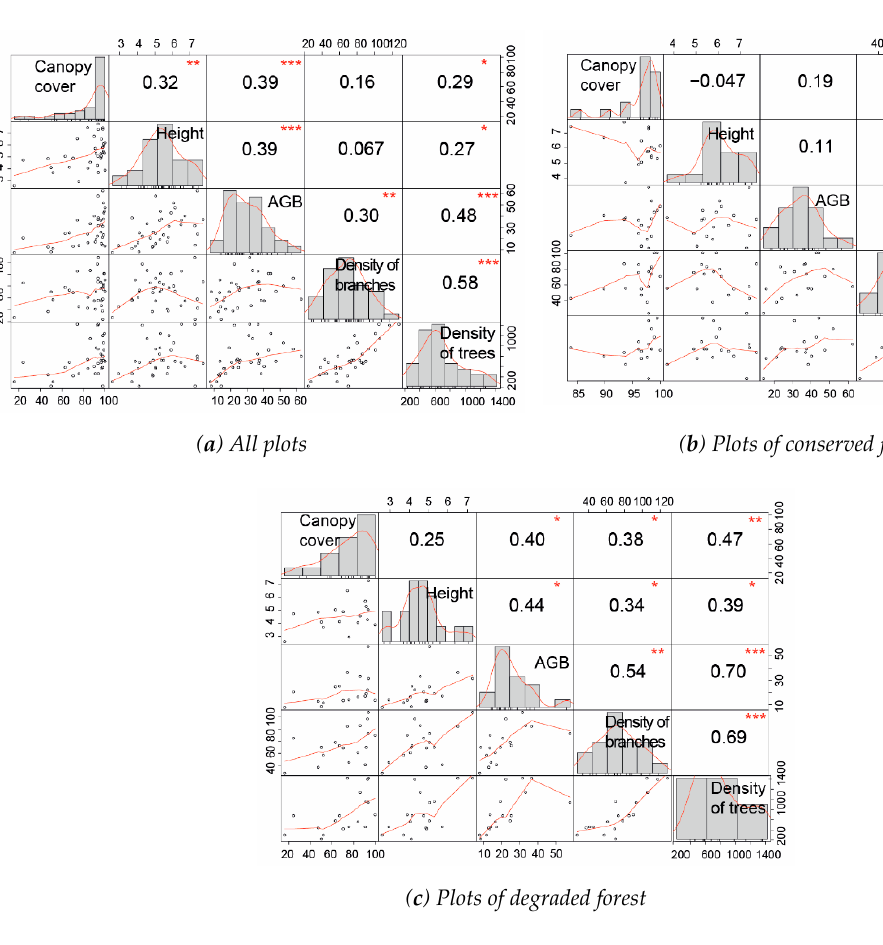
Figure 3. Correlation by Kendall’s tau between forest structural variables at the plot level. ( a ) for all plots ( n = 36), ( b ) for plots of conserved forest ( n = 18), ( c ) for plots of degraded forest ( n = 18). * p < 0.05, ** p < 0.01, *** p < 0.001. The histograms on the diagonal show the distribution of the variables and scatterplots on the lower left part of the figure show the correlation between the variables. The correlation coefficients (Kendall’s tau) are given in the cells in the upper right side of the figure.